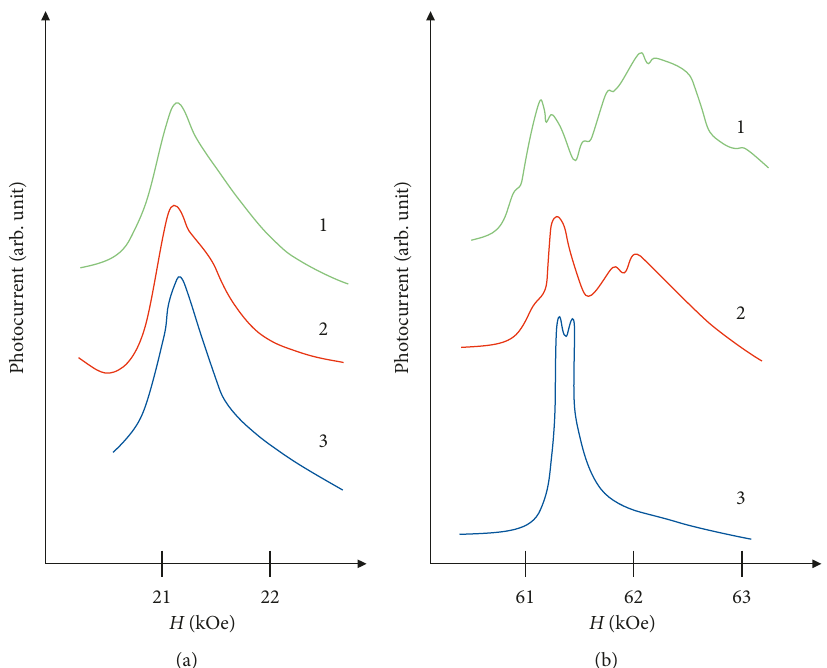
Figure 18: Low temperature ( T 2 V/cm corresponding to curves 1, 2, and 3, and aligned parallel to the magnetic field ε line in 1 b is due to the transition indicated by arrow ϵ 0 breakdown electric field.